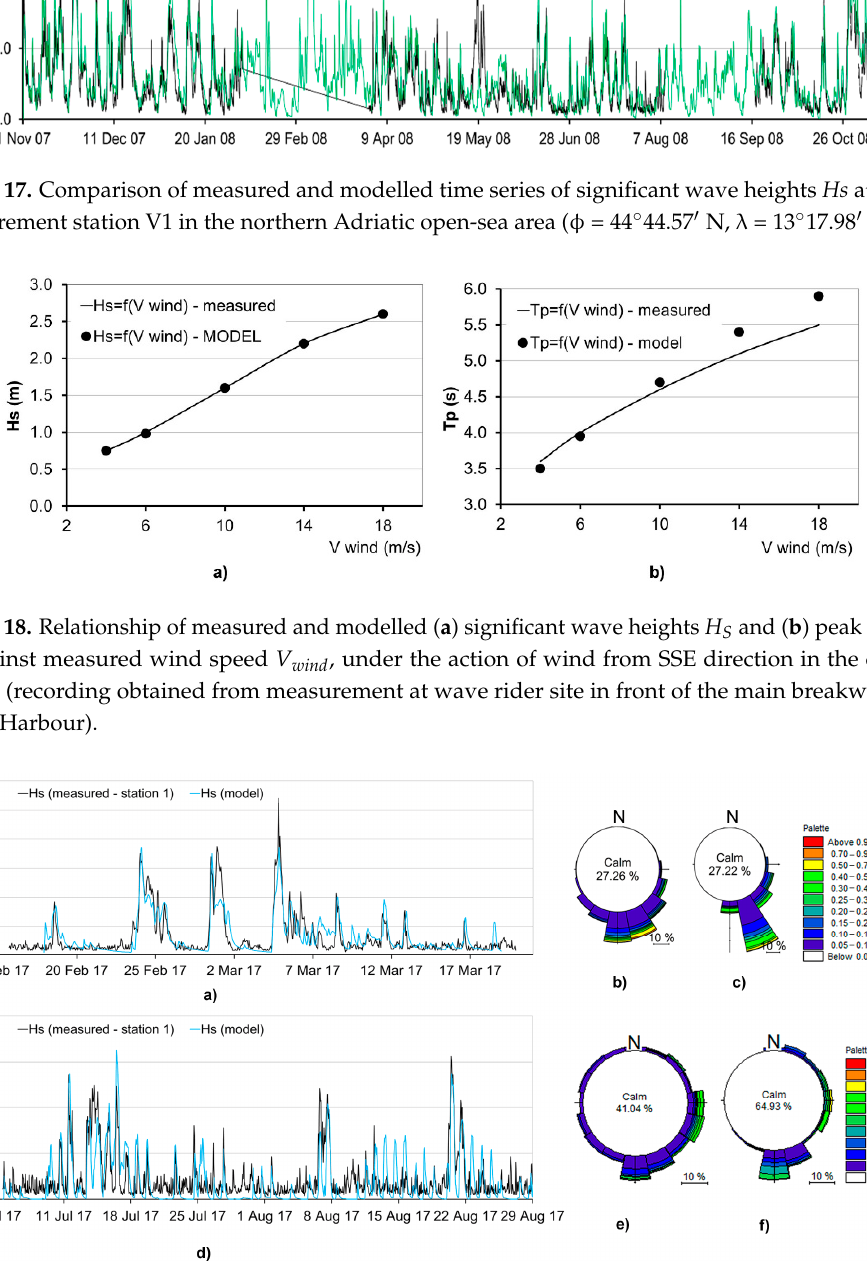
Figure 19. Comparison of measured and modelled time series of significant wave heights H S at measurement station 1 for the ( a ) winter and ( d ) summer measurement periods with corresponding wave roses from ( b , e ) measured and ( c , f ) modelled data.